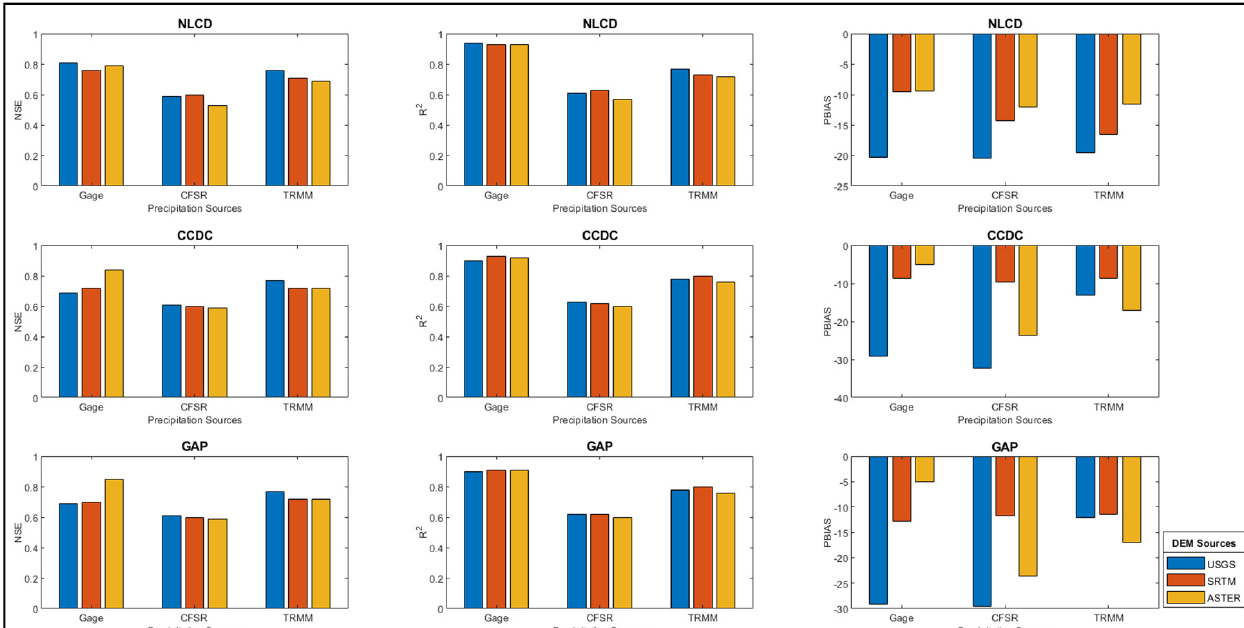
Figure 8. DEM and precipitation dataset comparison based on NSE, R 2 , and PBIAS values for NLCD; CCDC; and GAP LULC.